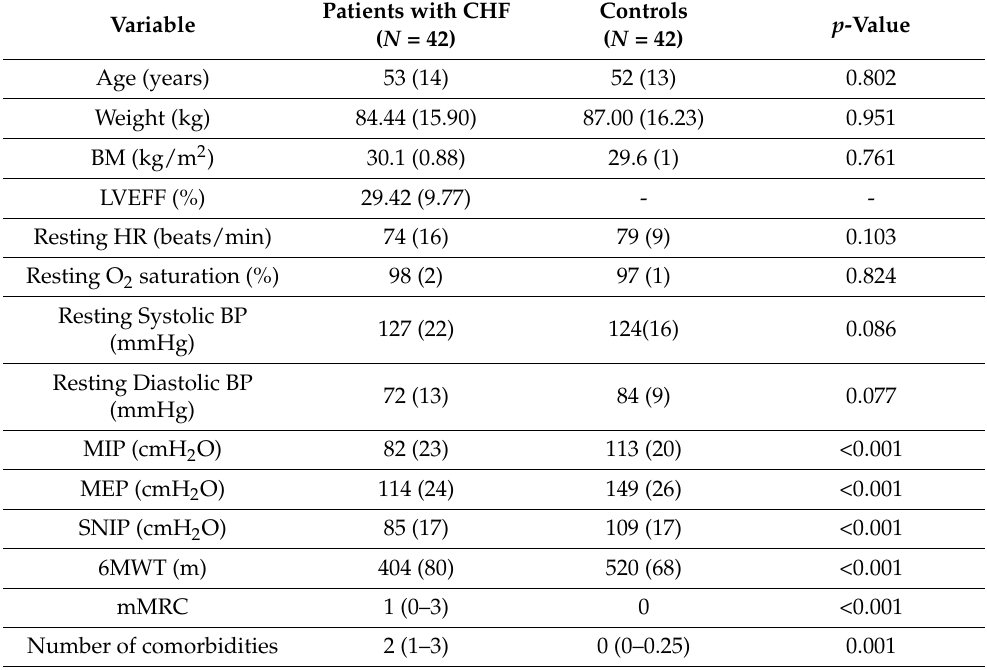
Table 1. Physical and clinical characteristics of